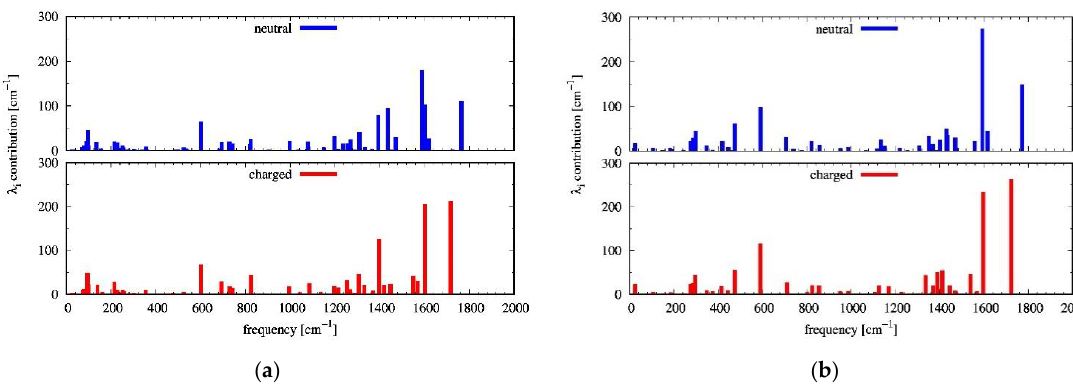
Figure 4. The vibrational frequency contributions (from HR factors, B3LYP/6-31G* level of theory) to the computed intramolecular reorganization energies λ i (for n-type charge transport) of ( a ) α -NDTI and ( b ) N-NDTI . Each graph shows the contribution from neutral species in the top part (blue bars) and from the negatively charged species in the bottom part (red bars). Table 2. Intramolecular reorganization energy λ i , effective frequency ω eff , and effective HR factor